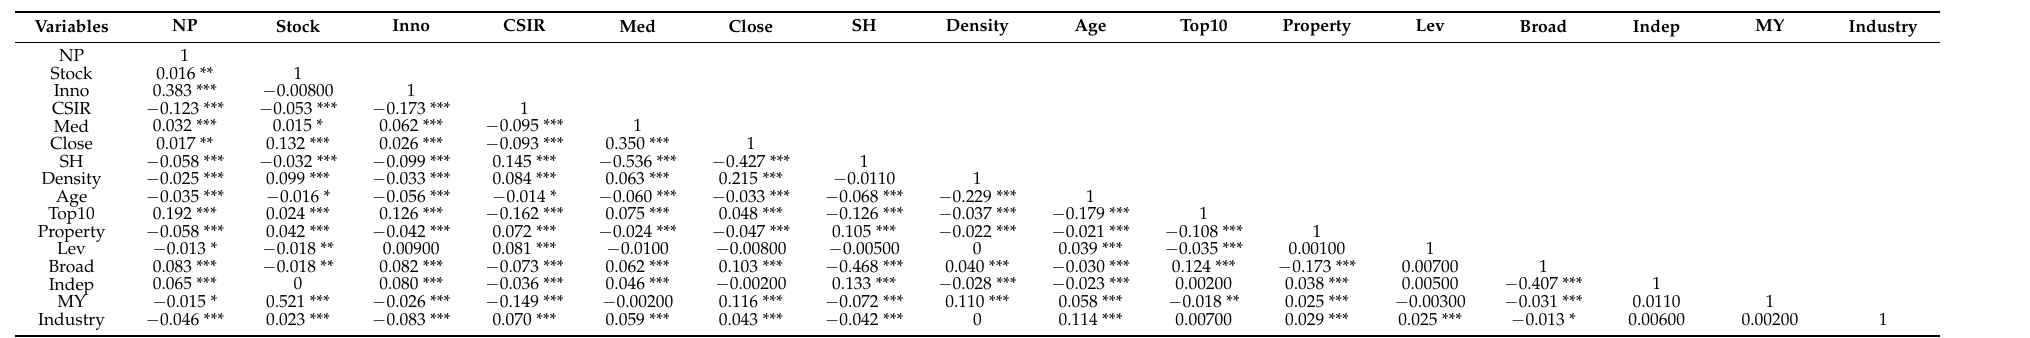
Table 2. Correlation